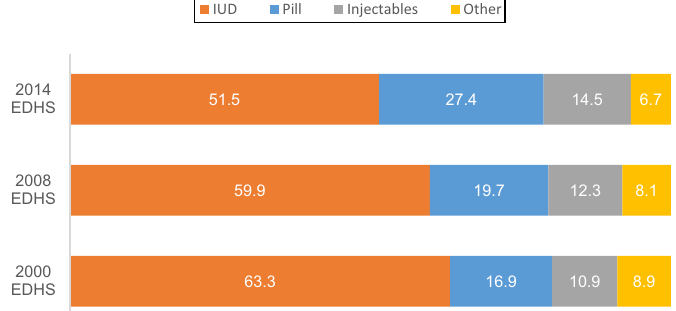
Figure 1. Trend in the